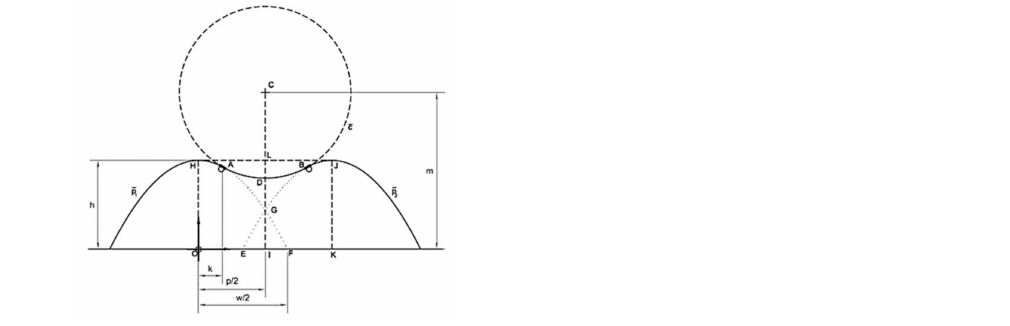
Figure 27. Overlapping parabolic field and fillet. Reprinted with permission from Ref. [71]. Copyright 2011 Elsevier.